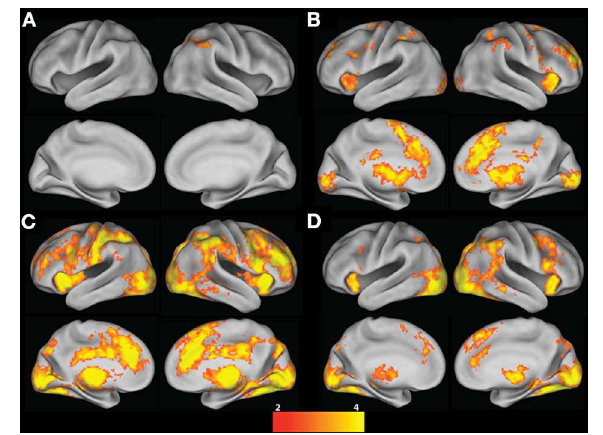
FIGURE 2 | ART group contrasts. (A) Risky choice; (B) Risky choice Parametric; (C) Cash-out; and (D) Loss contrasts (vs. Baseline). All contrasts are corrected for whole-brain multiple comparisons; statistical maps were projected onto an average cortical surface using CARET (Right hemisphere = Right side of the image). The color scale represents